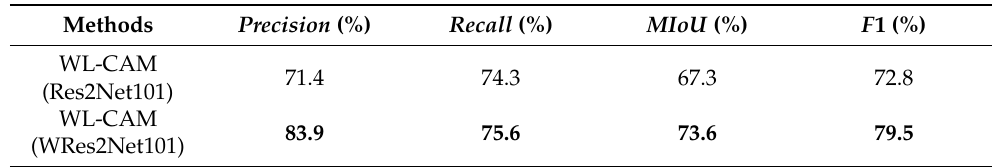
Table 10. Performance evaluation of WL-CAM with different backbone networks based on the proposed dataset.